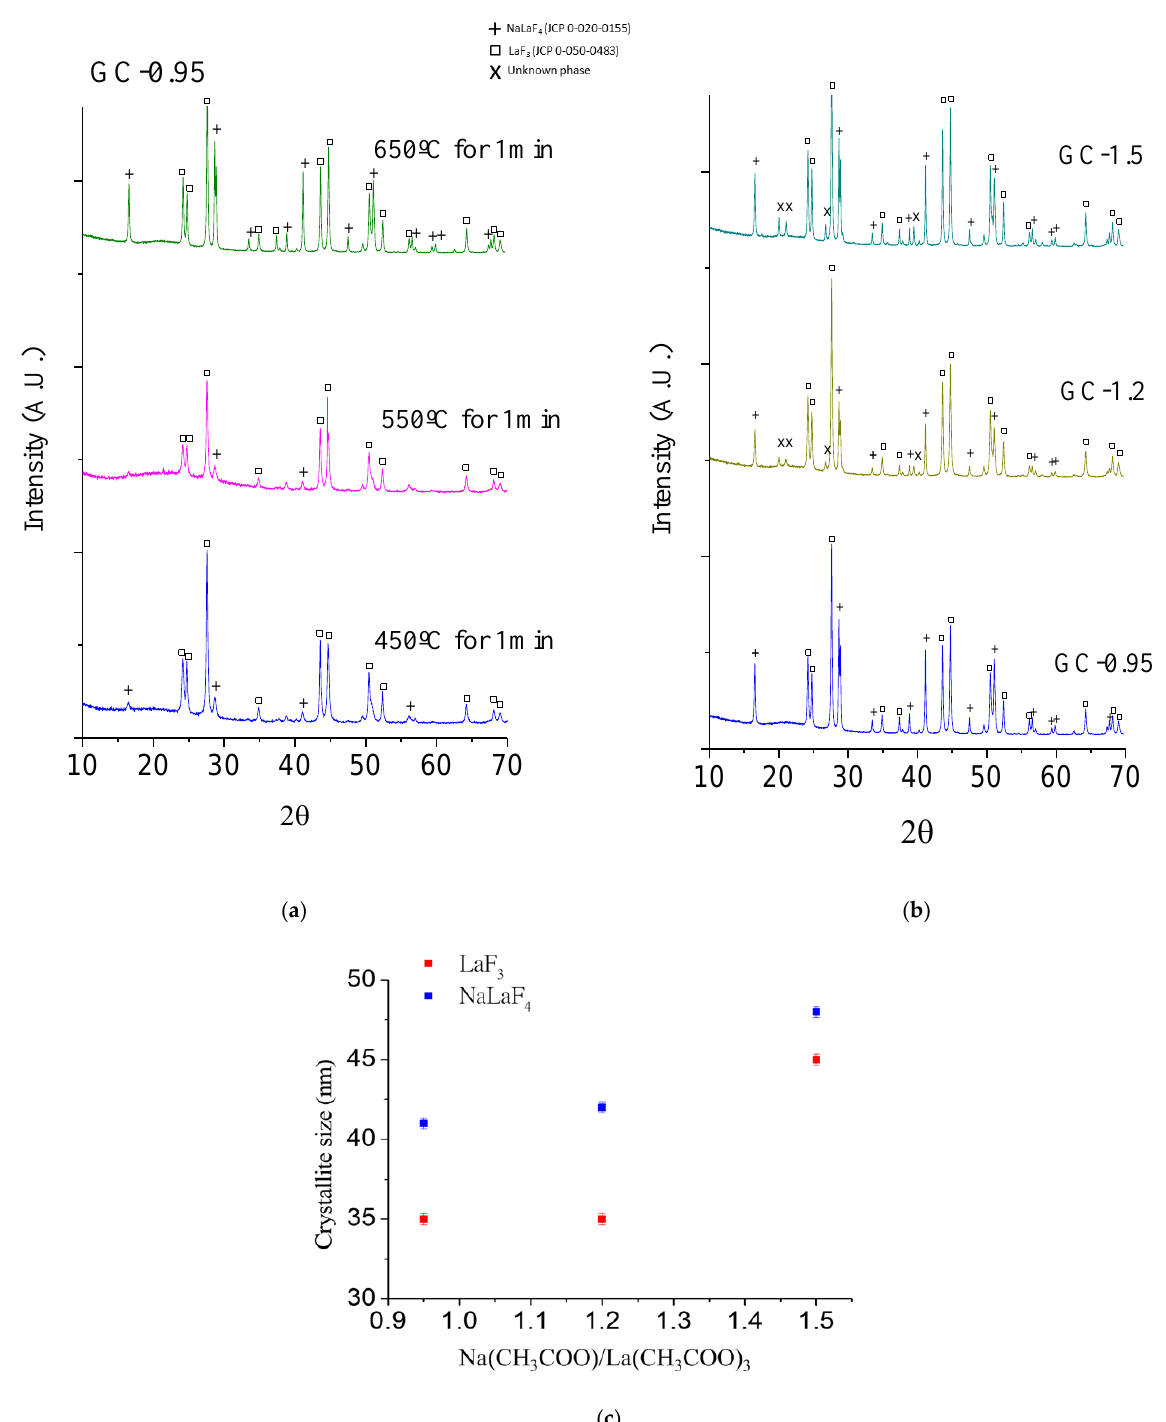
Figure 2. XRD pattern of ( a ) GC-0.95 treated with different temperatures for 1 min, ( b ) GC-0.95/1.2/1.5 treated at 650 °C for 1 min and ( c ) average crystallite size calculated with the Scherrer equation for SG-0.95/1.2/1.5 treated at 650 °C for 1 min. Table 2 . Relation of NaLaF 4 and LaF 3 phases in 80SiO 2 -20NaLaF 4 /LaF 3 GCs treated at 650 °C for 1 min estimated by Rietveld refinement (normalized to 100%).